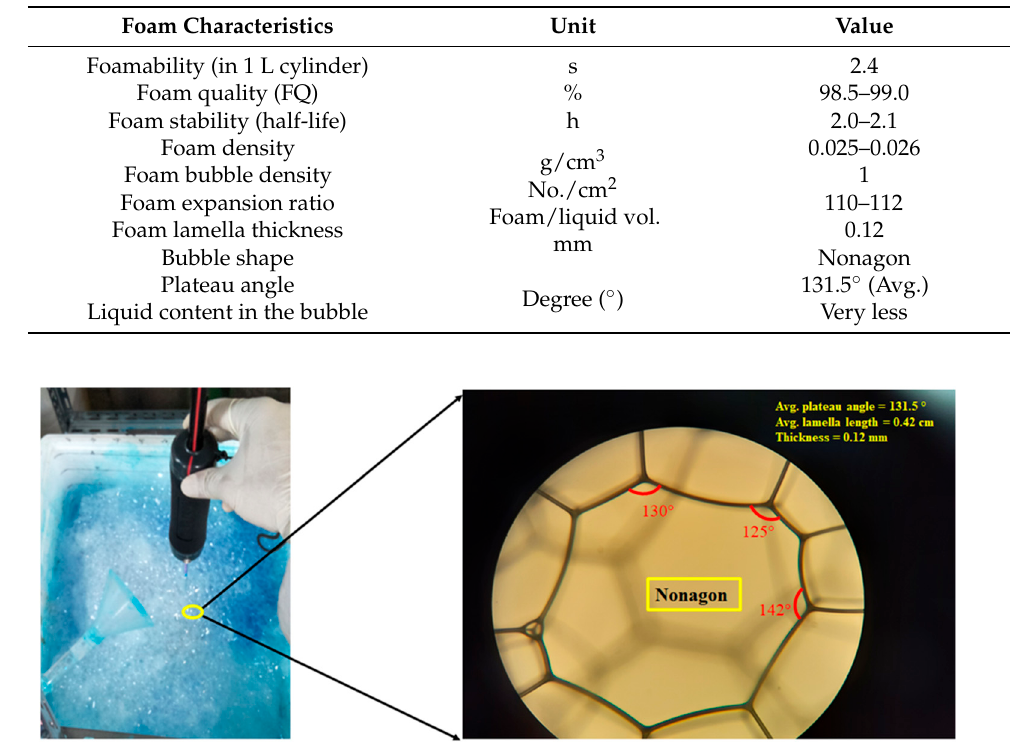
Figure 1. Characterization of a single foam